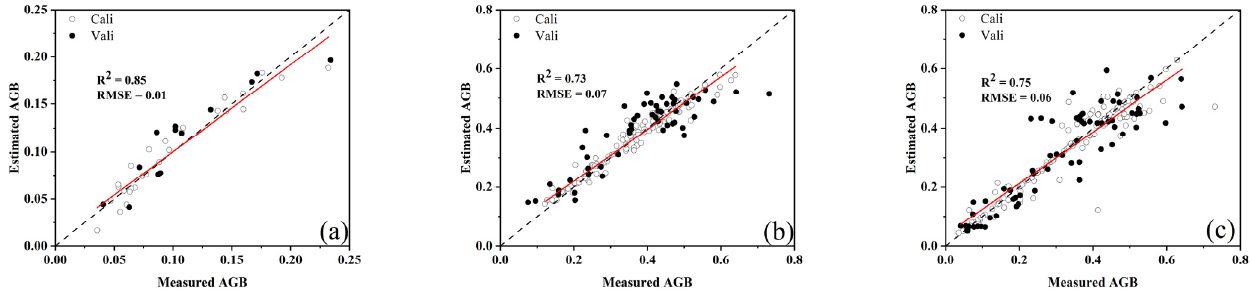
Figure 9. Validation of aboveground biomass (AGB) estimation models established by best per- forming optimal texture subset vs. AGB for the following stages: ( a ) seedling, ( b ) post-seedling, ( c ) all